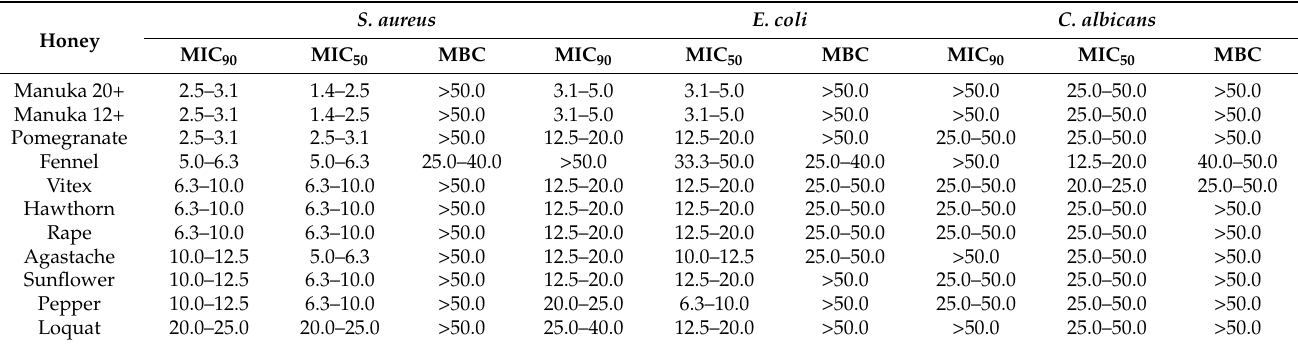
Table 4. Minimum inhibitory concentrations and minimum bactericidal concentrations of honey samples. The antimicrobial activity of honey was assessed against S. aureus , E. coli, and C. albicans.